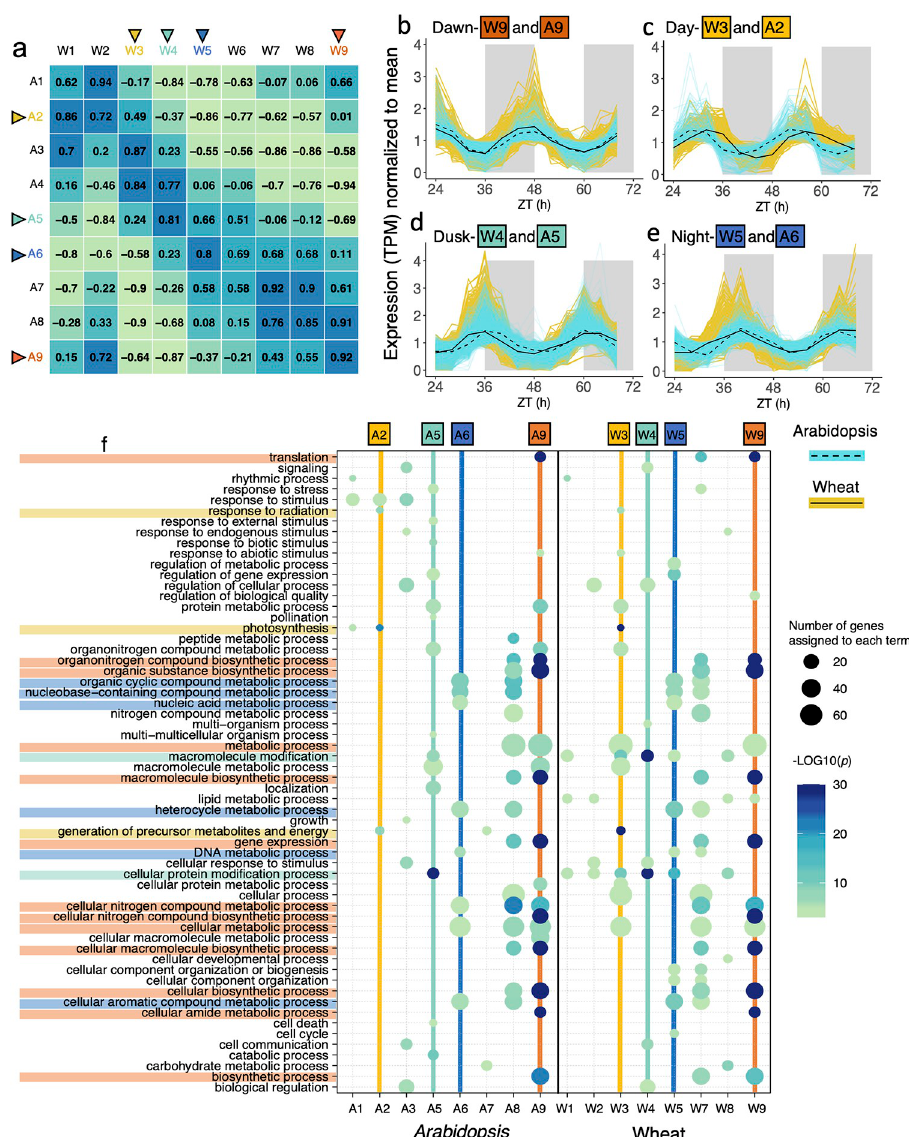
Fig 2. Overlapping GO-slim terms shared between Arabidopsis and wheat modules expressed at similar times in the day. Selected pairs of modules discussed in the main text in Arabidopsis and wheat are expressed at dawn (orange), day (yellow), dusk (turquoise), and at night (dark-blue). (a) Pearson correlation coefficient (r) between eigengenes for wheat and Arabidopsis expression modules ordered by circadian phase. (b–e) Expression profiles of selected Arabidopsis and wheat modules normalised to their mean. Solid and dashed black lines represent the module eigengene for wheat and Arabidopsis modules, respectively. (Data_Fig 2b-e in S1 Data). (f) GO-slim terms associated with genes in Arabidopsis and wheat modules. Terms are highlighted if they are shared by corresponding Arabidopsis and wheat modules. Modules are ordered by predicted CT phase for each species. Only terms with -Log10 p > 3 are shown. Wheat W6 and Arabidopsis A4 contained no terms above the significance cutoff and so are not shown. Bubble colour indicates the -Log10 p -value significance from Fisher’s exact test and size indicates the frequency of the GO-slim term in the underlying EBI Gene Ontology Annotation database (larger bubbles indicate more general